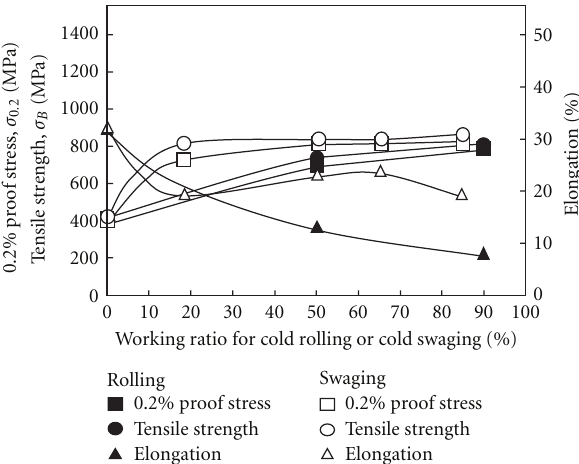
Figure 1: Tensile properties of TNTZ subjected to cold rolling or cold swaging as a function of working ratio.